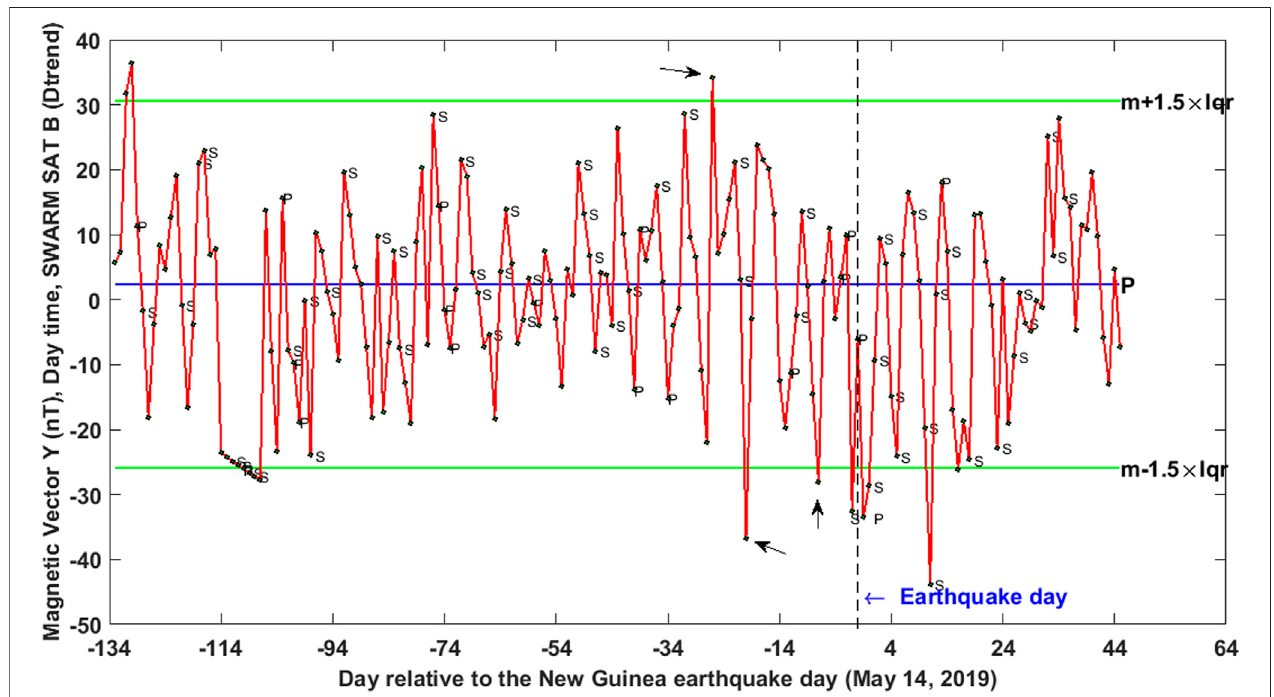
FIGURE5| ResultsofYmagnetic fi elddataanalysisfrom SwarmBfortheNewGuineaearthquake(May14,2019)fromJanuary01,toJune30,2019 atday time. The symbols “ P ” and “ S ” indicate disturbed magnetic days ( “ P ” according to magnetic indices, “ S ” according to solar